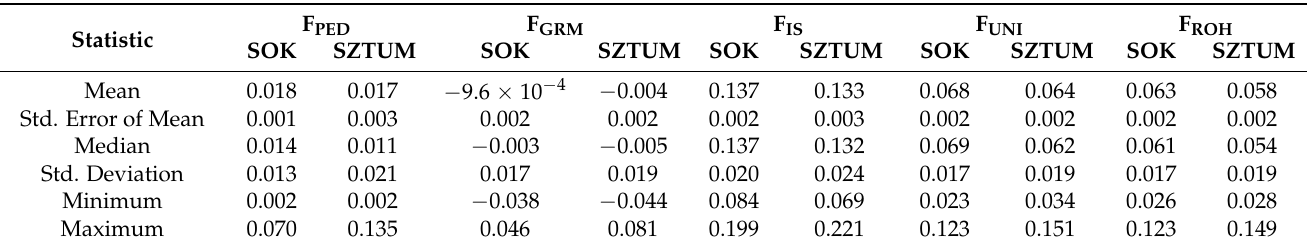
Table 3. Basic statistics for the analyzed inbreeding measures with respect to the analyzed horse types.